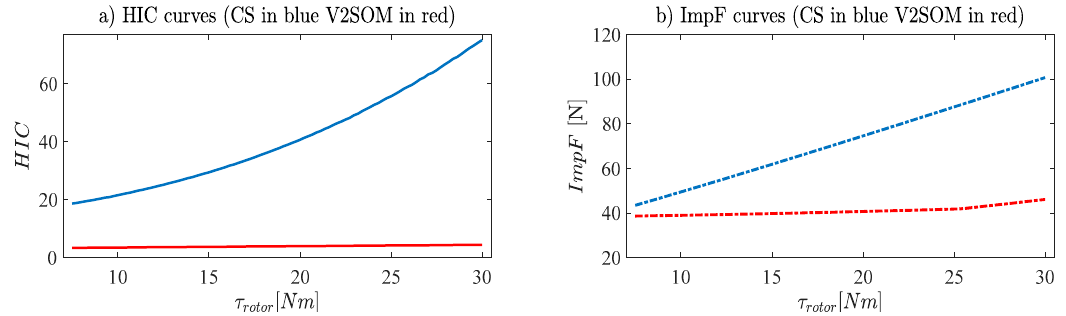
Figure 13. τ rotor impact on safety criteria, ( a ) HIC and ( b ) ImpF, for both V2SOM and CS Figure 13. 𝜏 (cid:3045)(cid:3042)(cid:3047)(cid:3042)(cid:3045) impact on safety criteria, ( a ) HIC and ( b ) ImpF, for both V2SOM and CS characteristics.